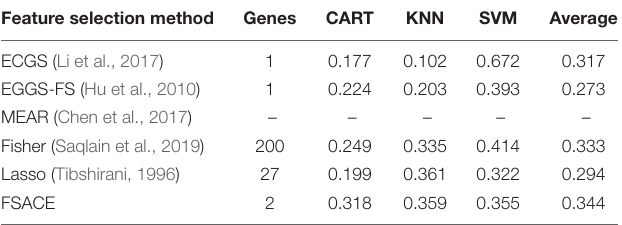
TABLE 7 | Classification accuracy of 9-tumors using six different feature selection algorithms.